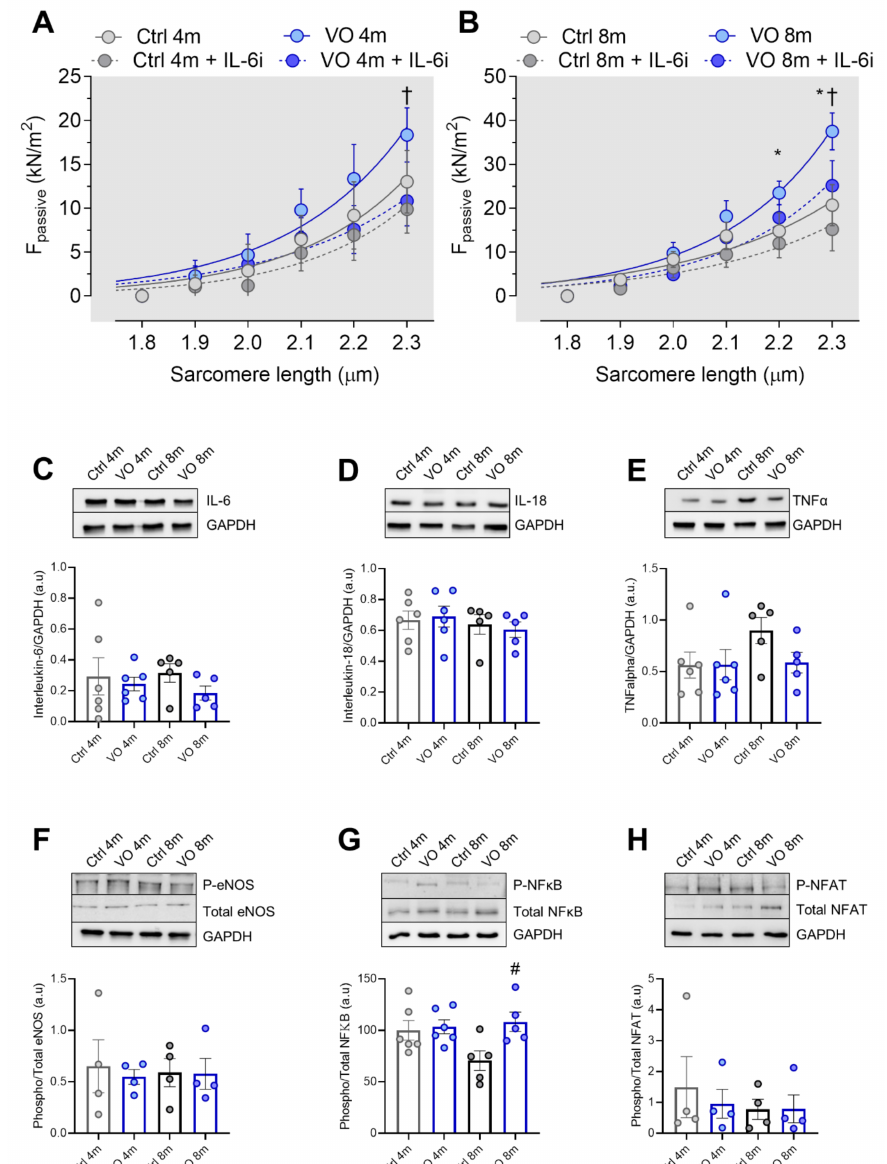
Figure 2. Inflammatory pathways. ( A ) Passive tension–sarcomere length relations of control (Ctrl) and volume overload (VO) cardiomyocytes in 4-month group with or without IL-6 inhibitor (IL-6i) treatment at sarcomere length (SL) 1.8–2.3 µ m. ( B ) Passive tension–sarcomere length relations of control (Ctrl) and volume overload (VO) cardiomyocytes in 8-month group with or without IL-6 inhibitor treatment at sarcomere length (SL) 1.8–2.3 µ m. All force recordings were normalized to cardiomyocyte cross-sectional area. Curves represent third-order polynomial regressions. Data are shown as nonlinear regression fit the means/medians; n = 5–6. * p < 0.05 Ctrl vs. VO 8-month, † p < 0.05; 8-month VO + IL-6i vs. 8-month VO, using one-way ANOVA Tukey multiple comparisons test. ( C ) Interleukin-6 protein level, ( D ) interleukin-18 protein level, ( E ) tumor necrosis factor alpha protein level, ( F ) phosphorylated/total endothelial nitrogen monoxide synthase (eNOS) protein ratio, ( G ) phosphorylated/total nuclear factor kappa B protein ratio, ( H ) phosphorylated/total nuclear factor of activated T-cells (NFAT) protein ratio. Data are shown as mean ± SEM; n = 4–6. * p < 0.05 4-months vs. 8-months, # p < 0.05 Ctrl vs. VO using one-way ANOVA Tukey multiple comparisons